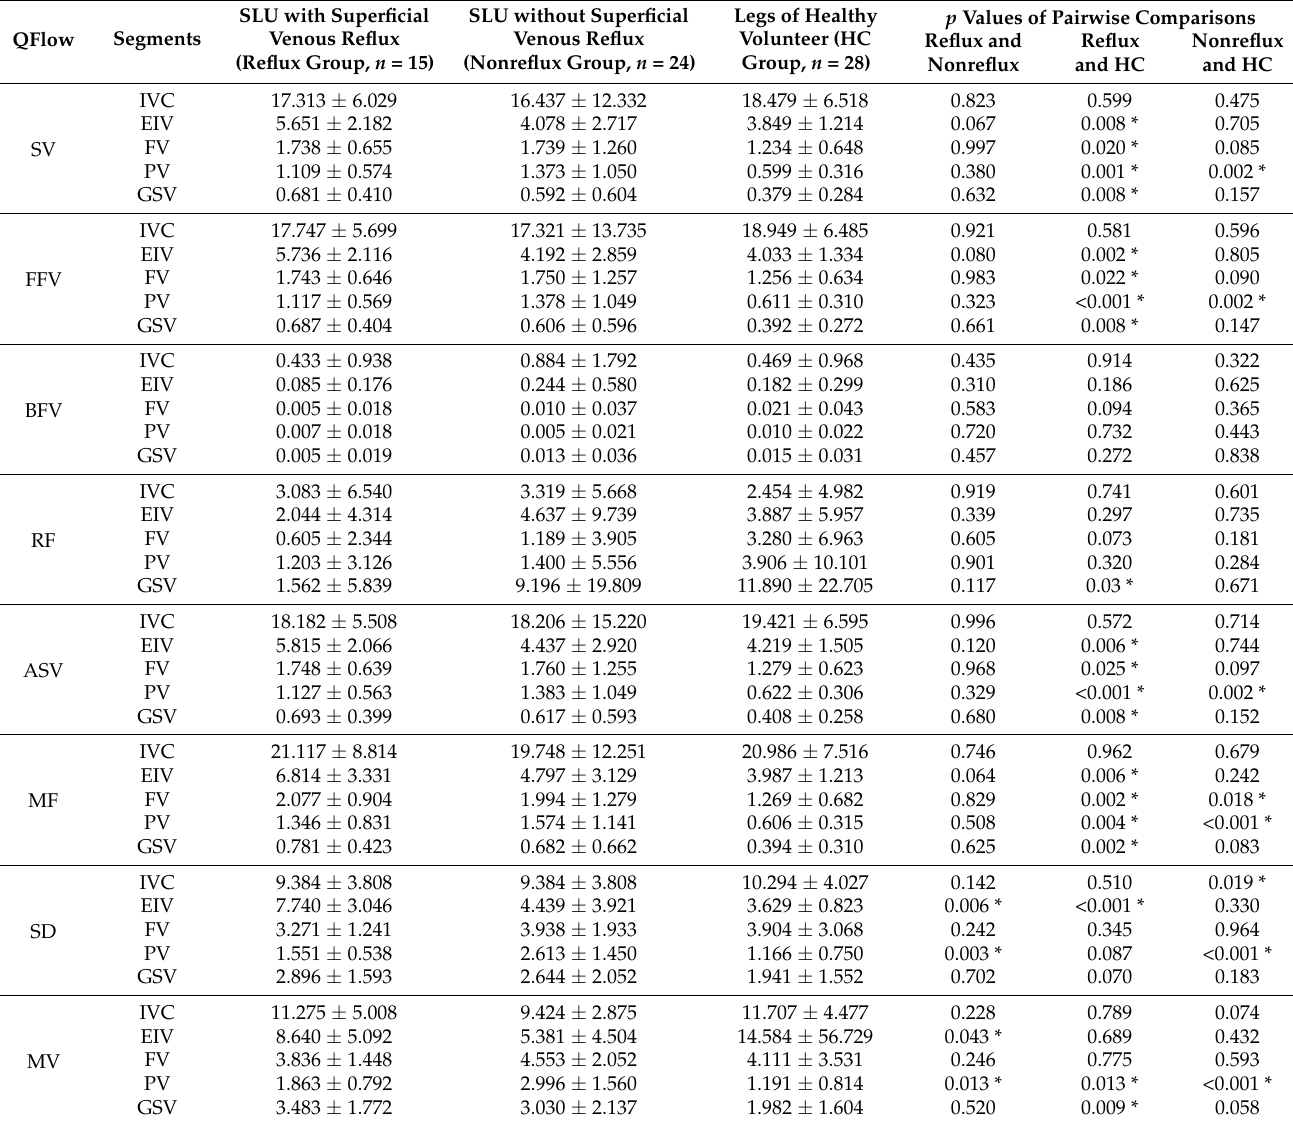
Table 3. Pairwise comparison of the QFlow parameters between diseased legs with reflux, without reflux, and healthy legs. QFlow